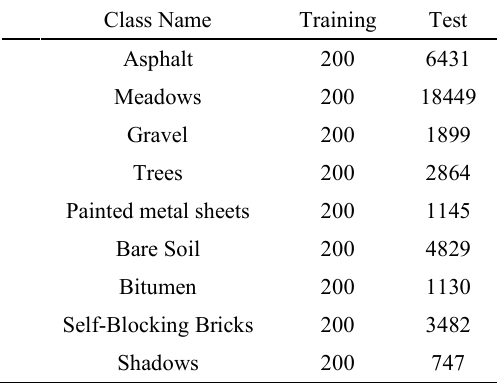
Table 1 . Number of training and test samples used in the Pavia